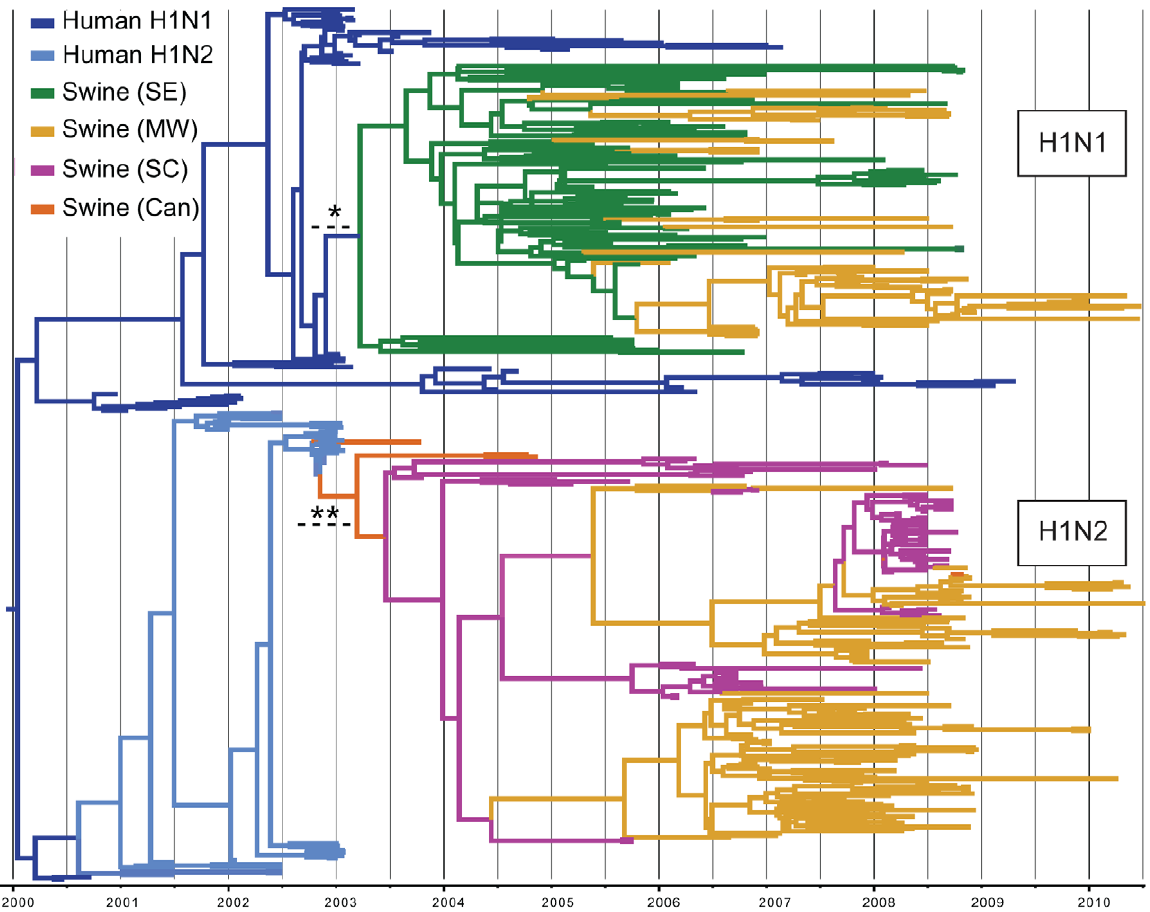
Figure 2. Phylogenetic relationships of 325 human H1-origin swine influenza viruses. Time-scaled Bayesian MCC tree of 325 HA1 (H1) sequences from human H1-origin influenza viruses collected from North American swine during 2003–2010, and 57 and 35 human H1N1 and H1N2 sequences, respectively, collected during 2000–2010 that are included as background. Tip labels have been removed (available in Fig. S10) and branches are colored by host species, subtype, and most probable location state: dark blue = human H1N1, light blue = human H1N2, green = swine influenza viruses collected in the Southeastern US (SE), yellow - swine influenza viruses collected in the Midwestern US (MW), magenta = swine influenza viruses collected in the South-central US (SC), and orange = swine influenza viruses collected in Canada (Can). Dotted lines with asterisks represent the estimated time period for human-to-swine transmission of H1N1 (*) and H1N2 (**) viruses, and posterior probabilities . 0.90 for key nodes are